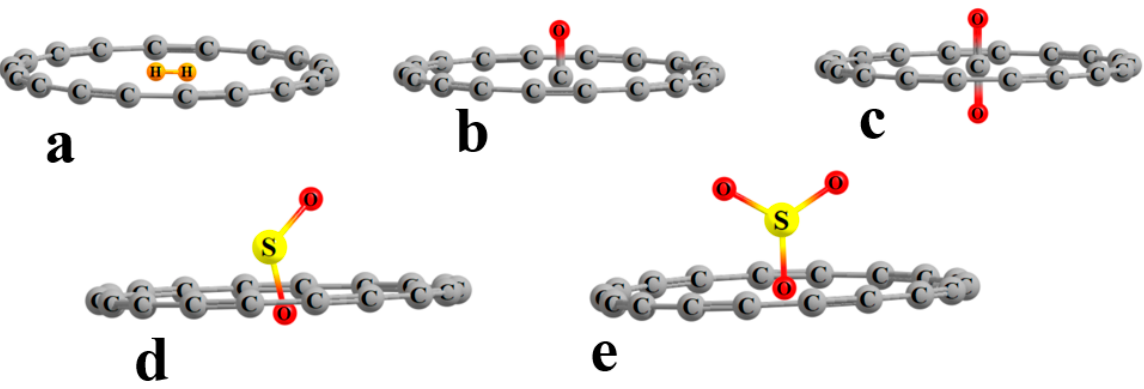
Figure 1. Geometries of complexes pairing C 18 with ( a ) H 2 , ( b ) CO, ( c ) CO 2 , ( d ) SO 2 , and ( e ) SO 3 .